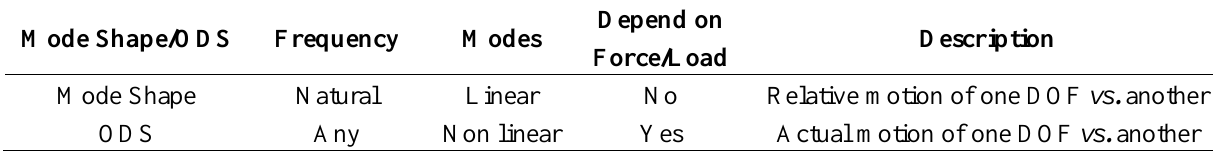
Table 1. Mode Shape and ODS comparative (adapted from Schwarz et al